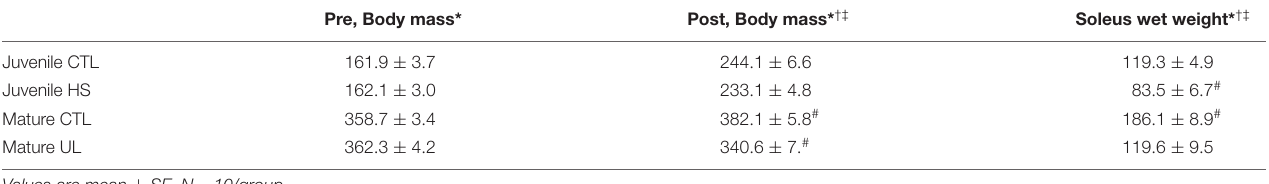
TABLE 1 | Body mass (g) before (Pre) and after (Post) the 2 week unloading intervention and soleus whole muscle wet weight (mg) after that intervention.